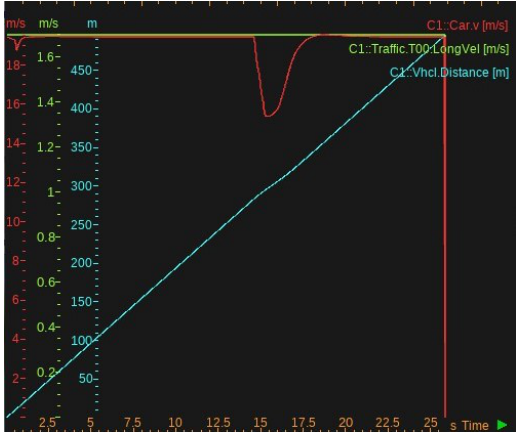
Figure 16. The collision happens at a distance of 300 m from the start.